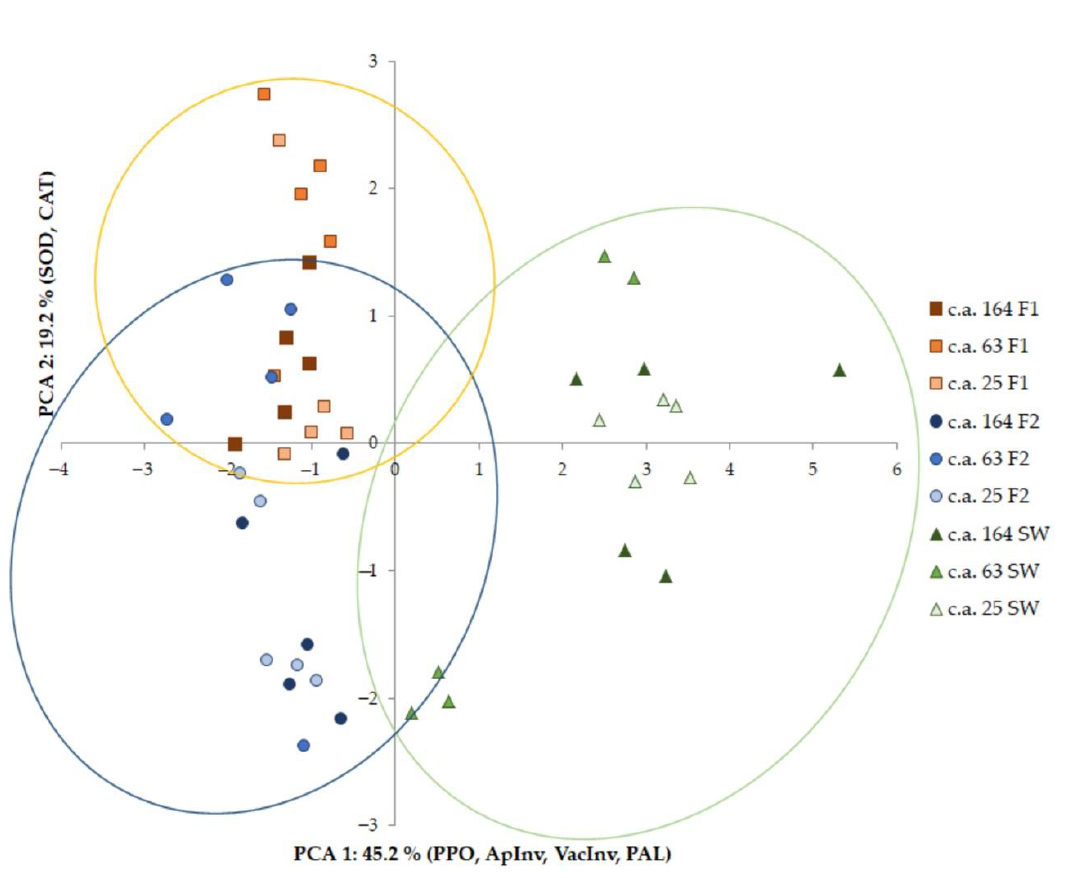
Figure 4. Ordination of 45 models based on enzyme activity. Factor 1 (45.2% of the variance) was correlated with PPO (r = 0.91), ApInv (0.92), VacInv (0.90), PAL (0.75), CtInv ( − 0.73), and POD ( − 0.62). Factor 2 (19.2% of the variance) was correlated with SOD (0.78) and CAT (0.66). The yellow grouping represents F1. The blue grouping represents F2. The green grouping represents SW. The values shown are means with 95% confidence intervals.